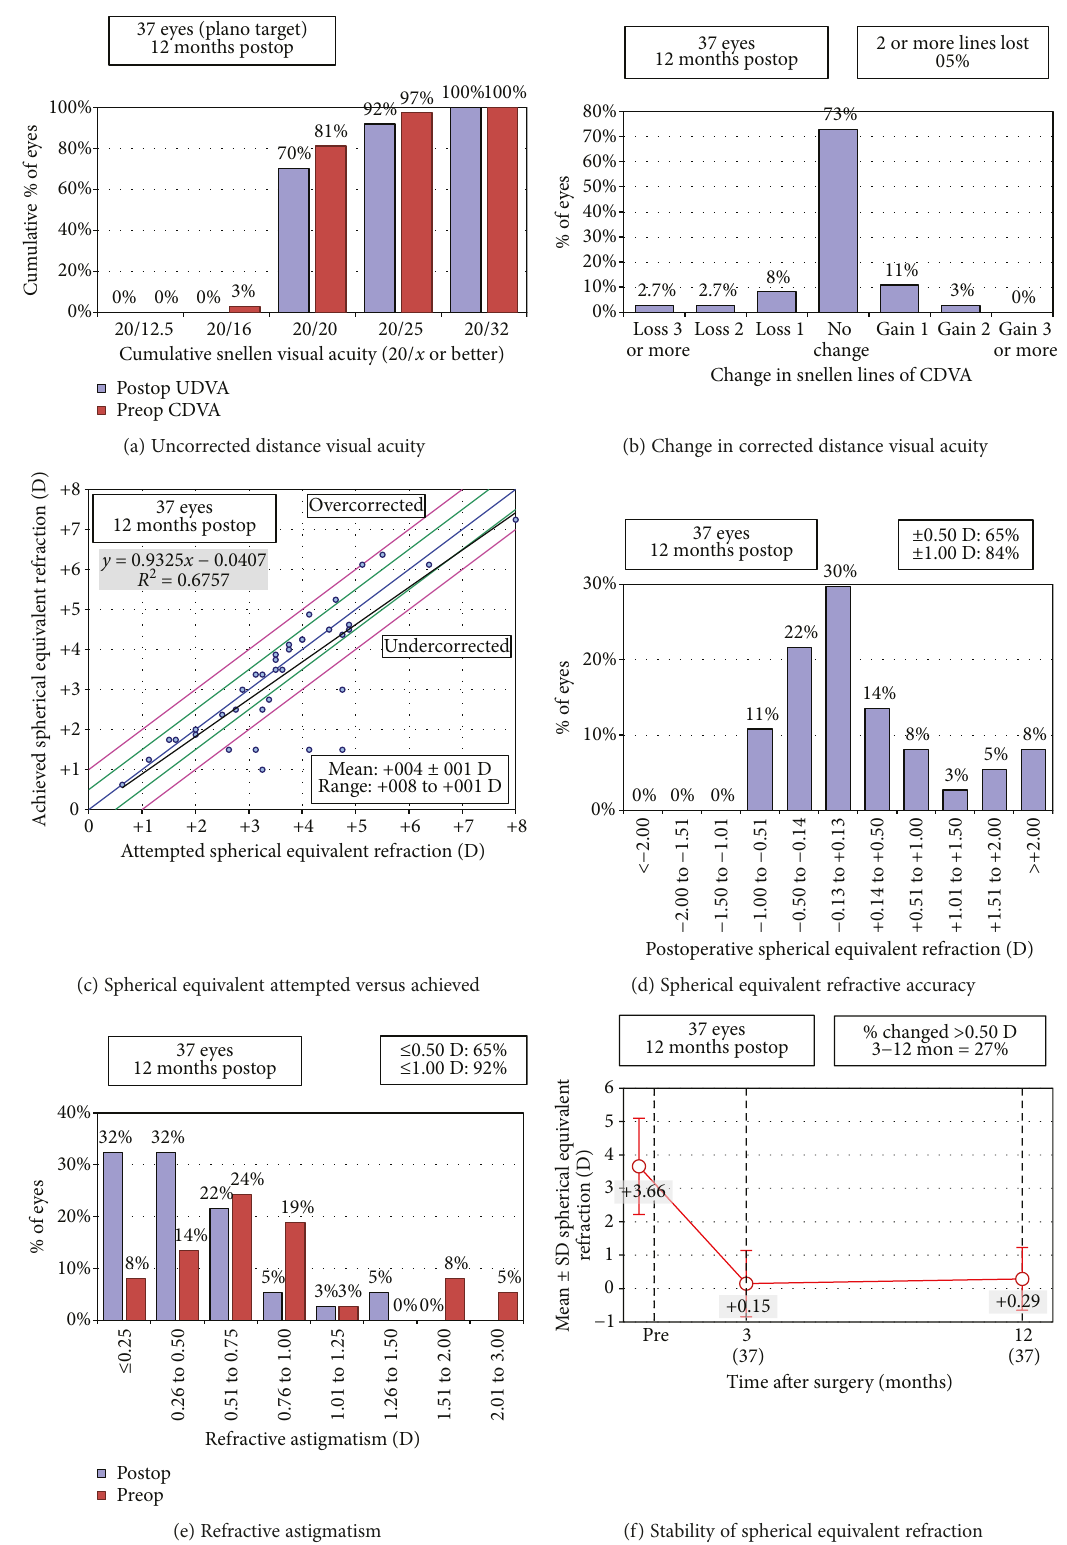
Figure 3: Clinical outcomes. Postoperative follow-up results (12 months after surgery). (a) Postoperative uncorrected visual acuity compared with the preoperative corrected distance visual acuity (CDVA). (b) Changes in lines of CDVA. (c) Intended versus achieved correction (manifest refraction). (d) Distribution of postoperative spherical equivalent (predictability). (e) Distribution of preoperative and postoperative astigmatism. (f) Stability of the manifest